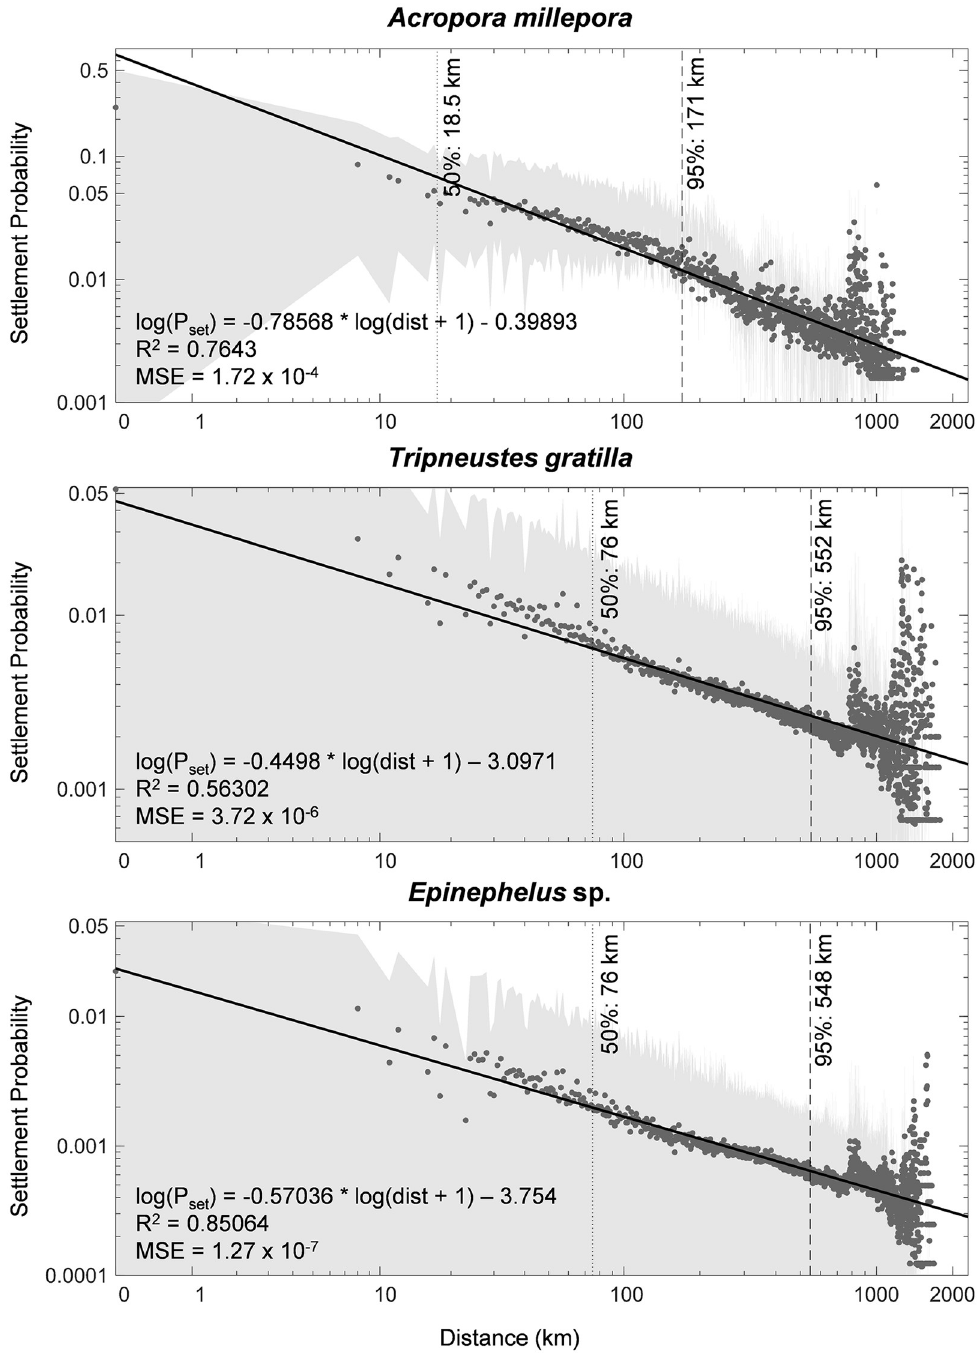
Fig 2. Fitted power law functions from dispersal kernels of each model organism. Dark gray dots are the mean settlement probability ( P set ) of each source-to-sink distance (dist) with gray areas showing the standard deviation. Note that the axes are in log scale and the limits of the y-axis varies. Verticals lines show the distance of connections at the median (dotted) and at 95 th percentile (dashed) of connections.